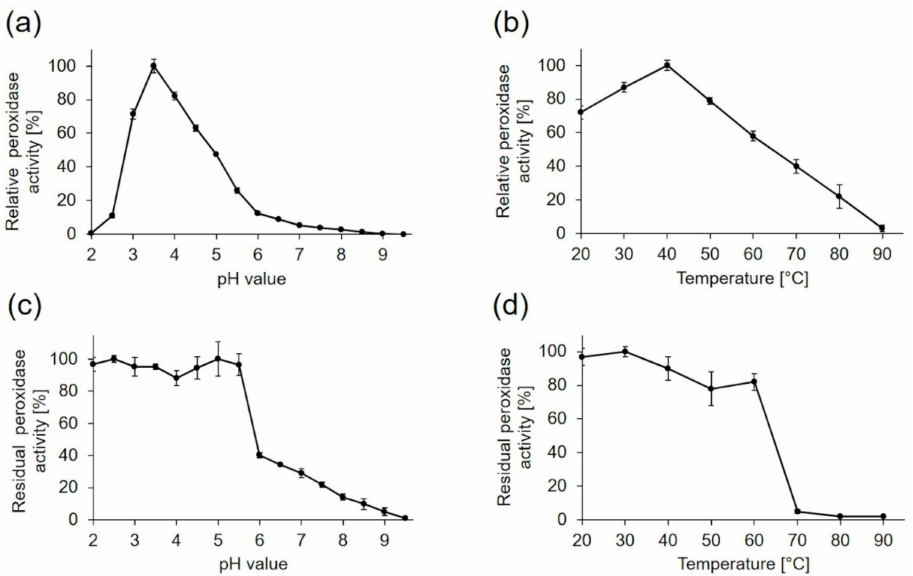
Figure 5. Influence of pH and temperature on activity and stability of PsaPOX. The pH optimum ( a ) was determined to be 3.5 and the temperature optimum ( b ) 40 ◦ C. Relative peroxidase activity [%] was defined as the percentage of activity detected with respect to the highest activity in each experiment. pH stability ( c ) was determined after incubation of PsaPOX in Britton Robinson bu ff er ranging from pH 2.0 to 9.5 for 1 h at RT and temperature stability ( d ) after incubation at 20 to 90 ◦ C and pH 3.5 for 1 h. Residual activities were determined at pH 3.5 and 40 ◦ C. Values are the average of triplicate experiments with standard deviations shown as error